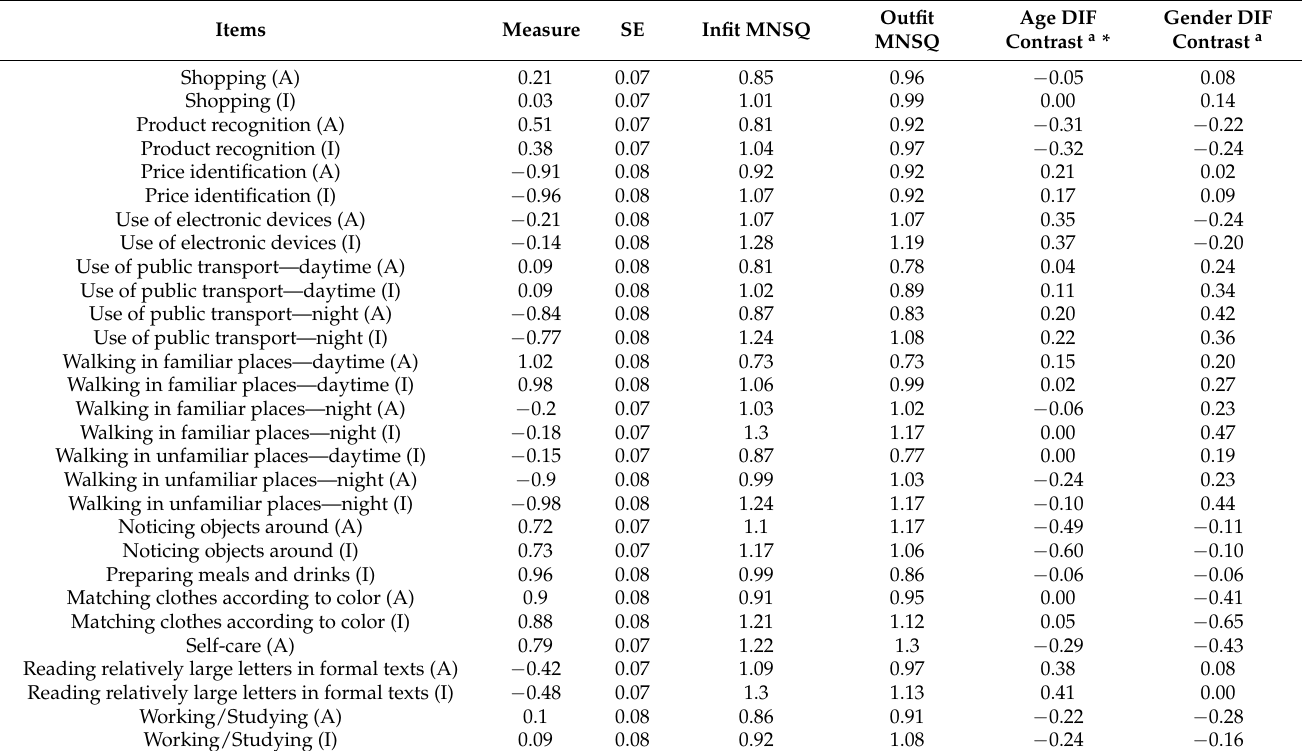
Table 3. Estimates of item measures and fit statistics from Rasch analysis for the